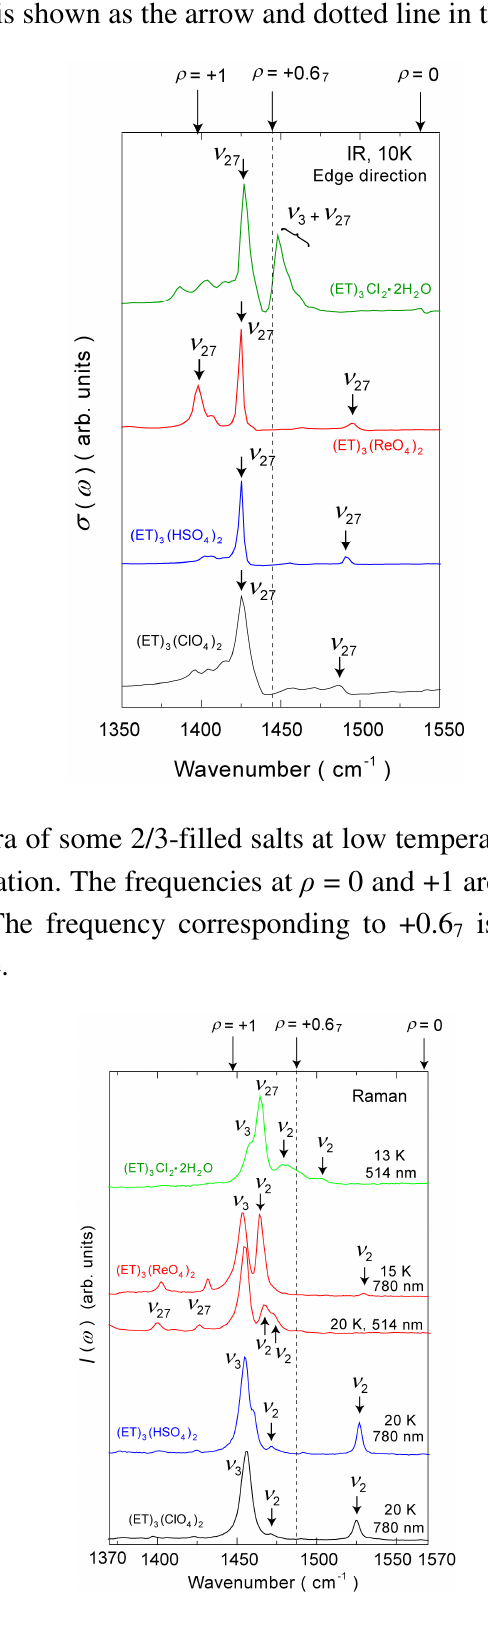
Figure 8. The ν modes of some 2/3-filled salts at low temperature. The frequencies at 27 ρ = 0 and +1 are denoted by the arrows on the top of the panel. The frequency corresponding to +0.6 is shown as the arrow and dotted line in this figure. 7